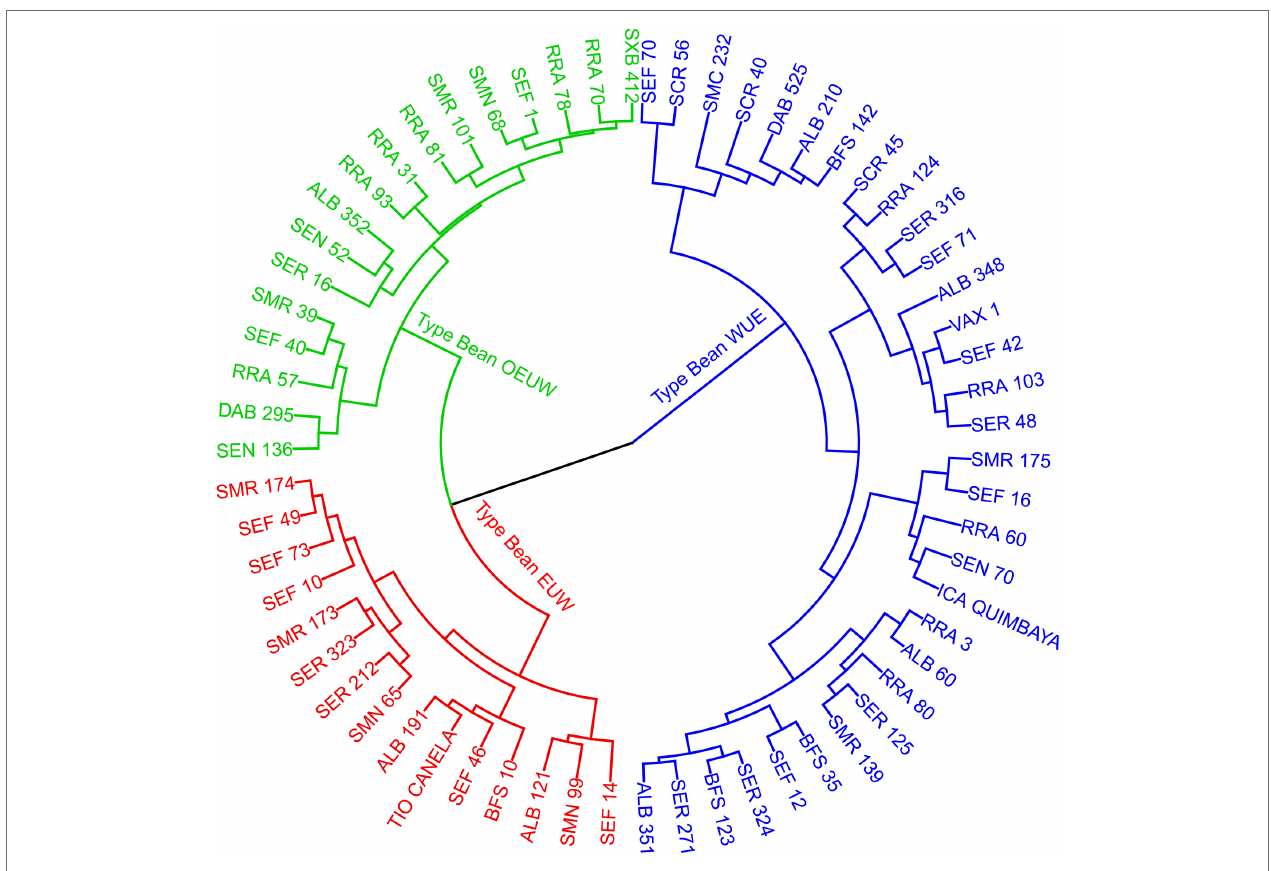
FIGURE 6 | Dendrogram (method Ward, Euclidean distance) showing the different typologies of common bean genotypes grouped by different physiological variables ( Table 1 ) cultivated at high temperatures. EUW; Effective Use of Water, WUE; Water use efficient, OEUW; Opportunistically effective use of